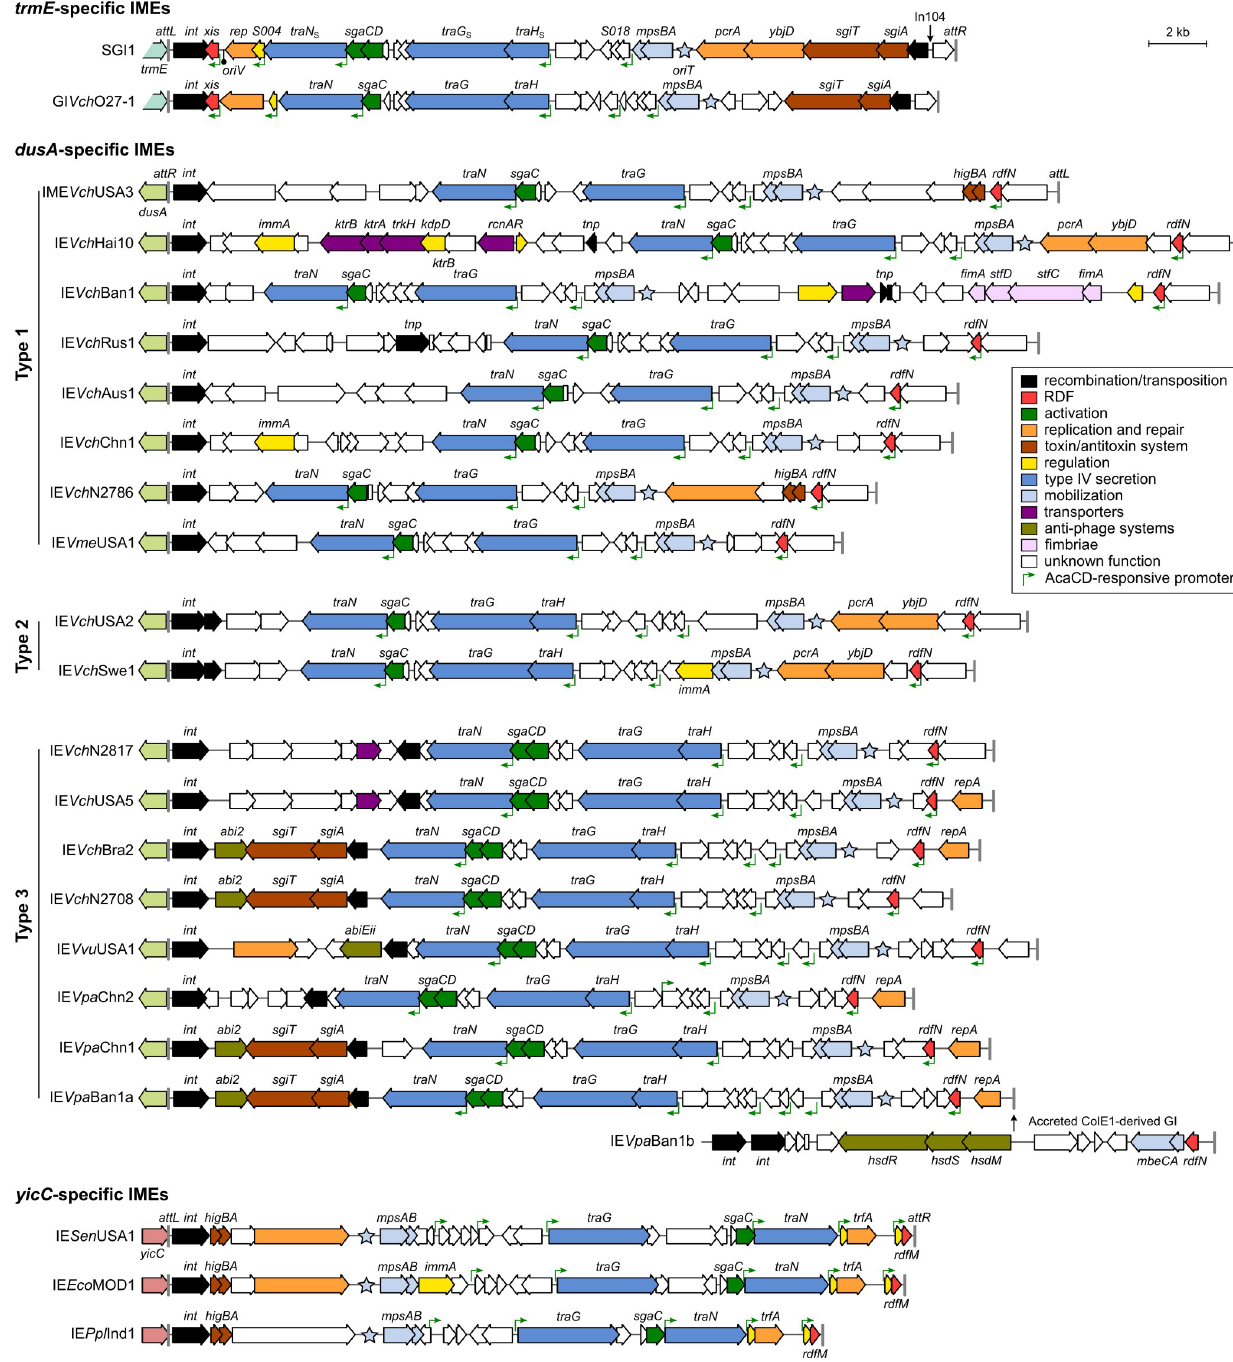
Fig 1. Schematic representations of SGI1-related IEs. The position and orientation of open reading frames (ORFs) are indicated by arrowed boxes. Colors depict the function deduced from functional analyses and BLAST comparisons. Potential AcaCD binding sites are represented by green angled arrows. Each island is flanked by the attL and attR (vertical grey lines) attachment sites when integrated into the 3’ end of trmE (light blue), the 5’ end of dusA (light green), or the 3’ end of yicC (pink). The annotation of attL and attR relative to int is based on SGI1 ( trmE ) [9], IE Aba D1279779